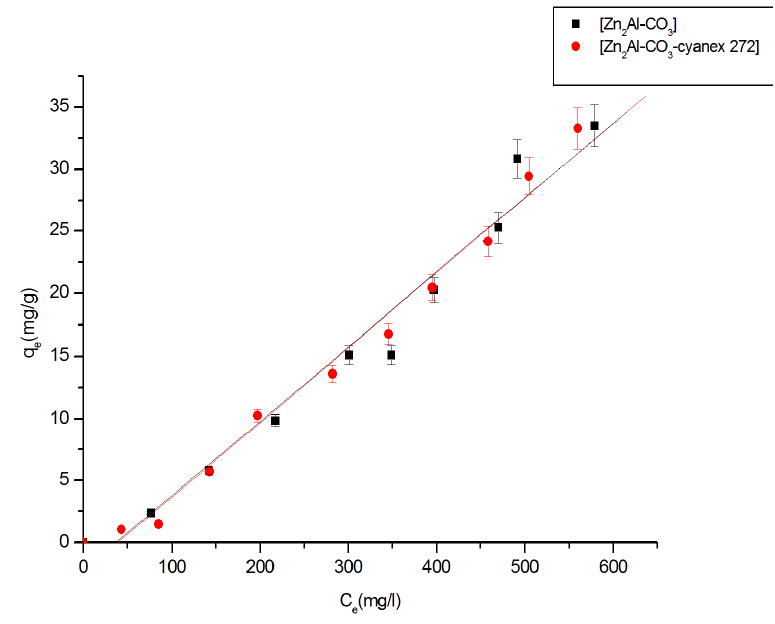
Figure 10. Isotherms of Zn(II) extraction (pH 0 = 1.00 ± 0.05 [Zn + 2 ] = 100 mg.L − 1 , [Na + , H + -NO 3 − ] = 0.1 M, T = 25 °C).